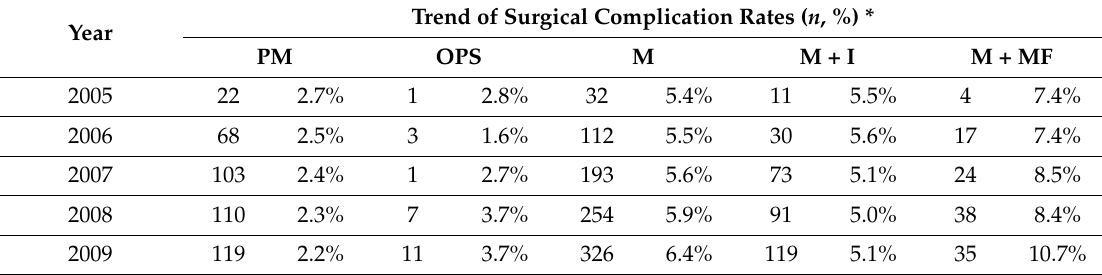
Table 5. Trend of Surgical Complication Rates ( n , %)